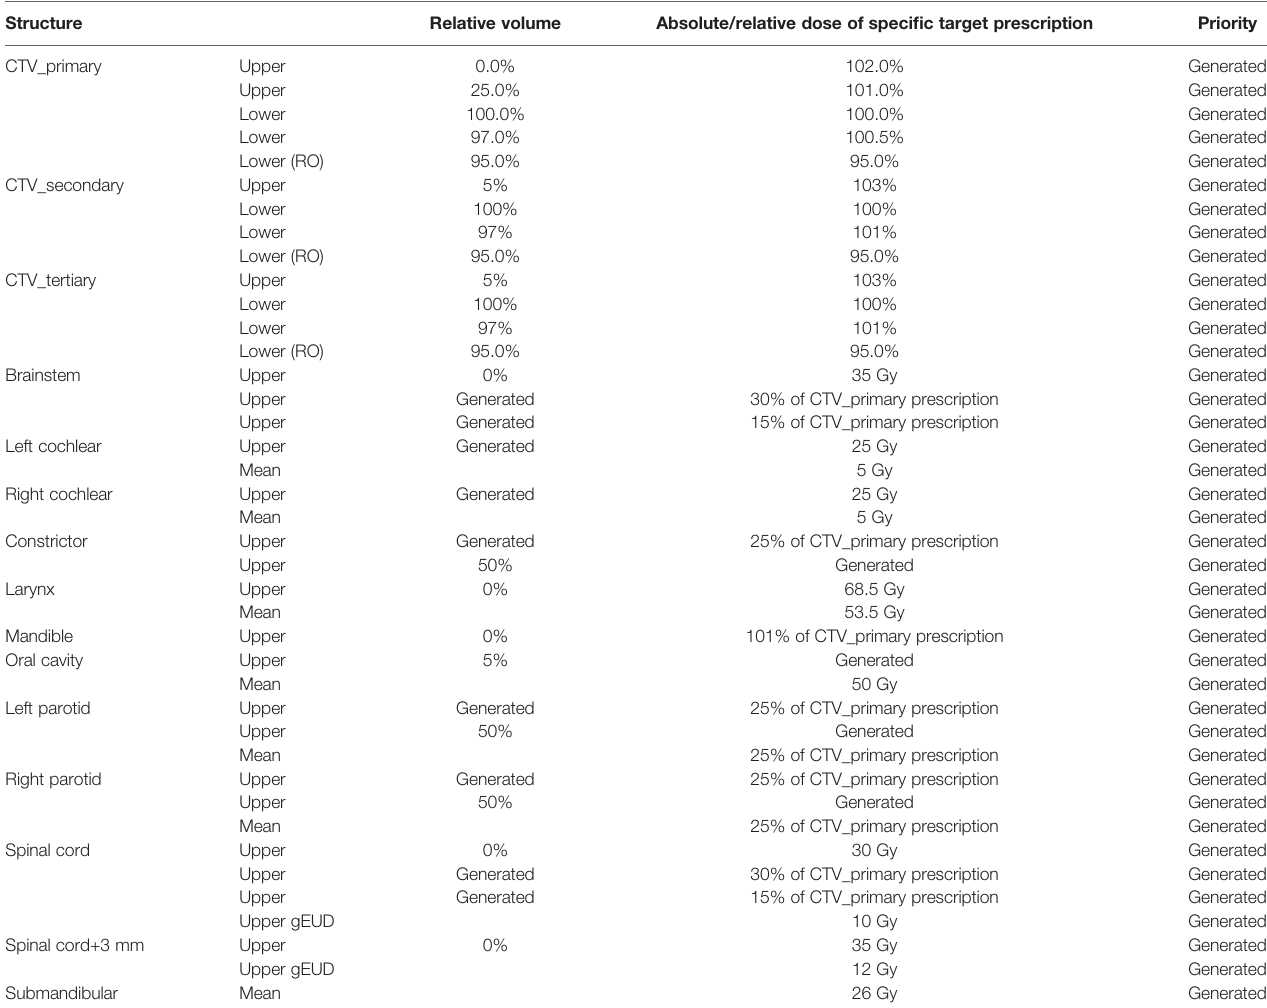
TABLE 2 | Objectives implemented in the